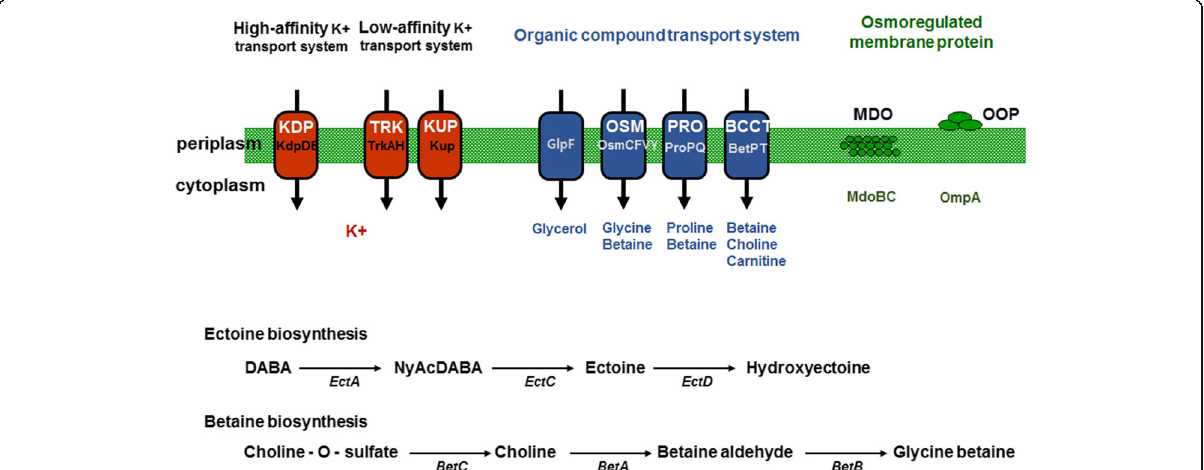
Fig. 4 Genomic prediction of the osmoregulation in K. konosiri X49 T . Trk, K + transport; KUP, K + uptake permease; Kdp, K + -dependent ATPase; BCCT, betaine-carnitine-choline transport; Osm, osmotically inducible protein; MDO, membrane-derived oligosaccharides; OOP, OmpA-OmpF Porin; EctA, L-2,4-diaminobutyric acid acetyltransferase; EctC, L-ectoine synthase; EctD, ectoine hydrolase; BetA, choline dehydrogenase; BetB, betaine aldehyde dehydrogenase; BetC, choline sulfatase protein